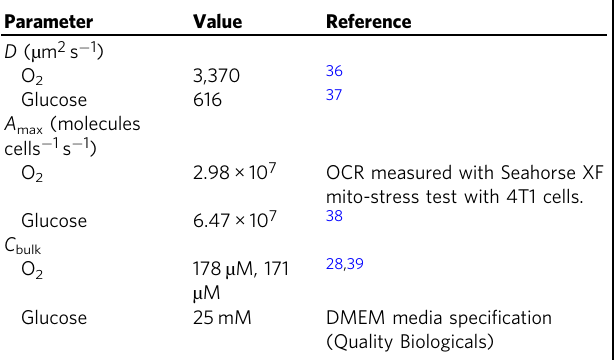
Table 1 REEC/4T1 diffusion-consumption model